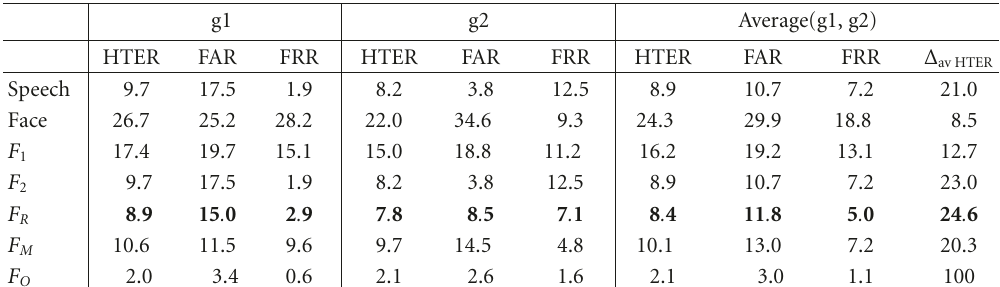
Table 4: Error rates (HTER, FAR (false accept rate), FRR (false reject rate)), in percent, for speech and face baseline classifiers and for di ff erent decision fusion methods. Conflicting classifier decisions are resolved by picking a decision F 1 at random, F 2 always from the classifier more accurate on the training set (here-speech), F R according to the higher reliability estimate, F M according to a higher margin-derived confidence measure, and F O from an oracle that always picks the classifier that makes a correct decision. Column Δ avHTER gives relative performances with respect to the oracle.